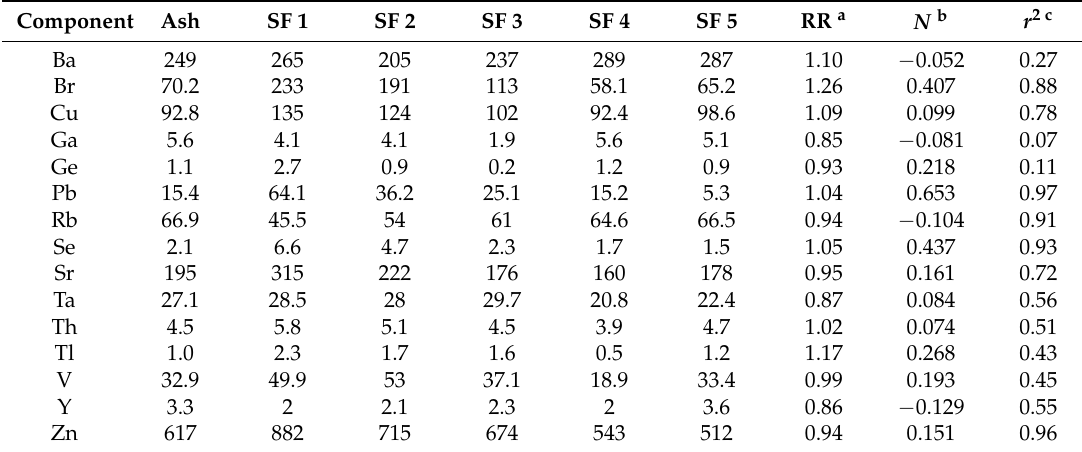
Table 3. Concentration of heavy metals and other minor elements in the fly ash size fractions (in mg/kg